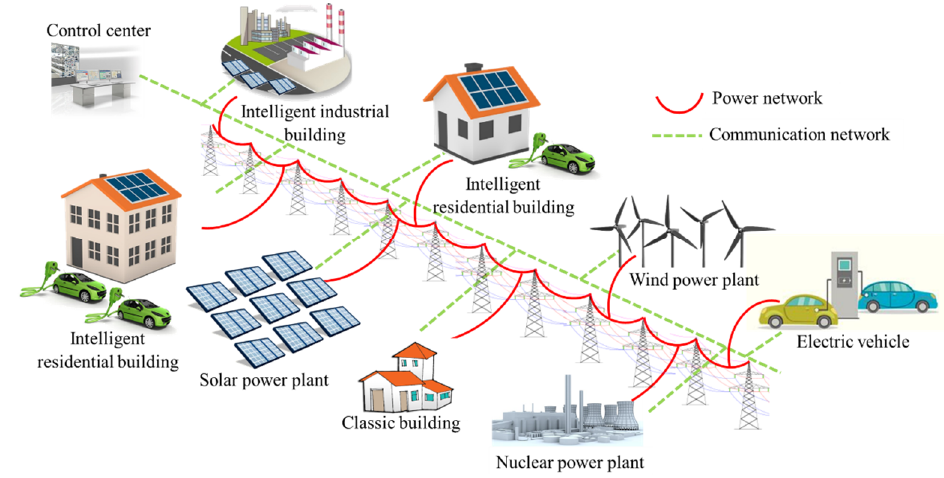
Figure 3. Intelligent buildings as systems within the whole smart grid.